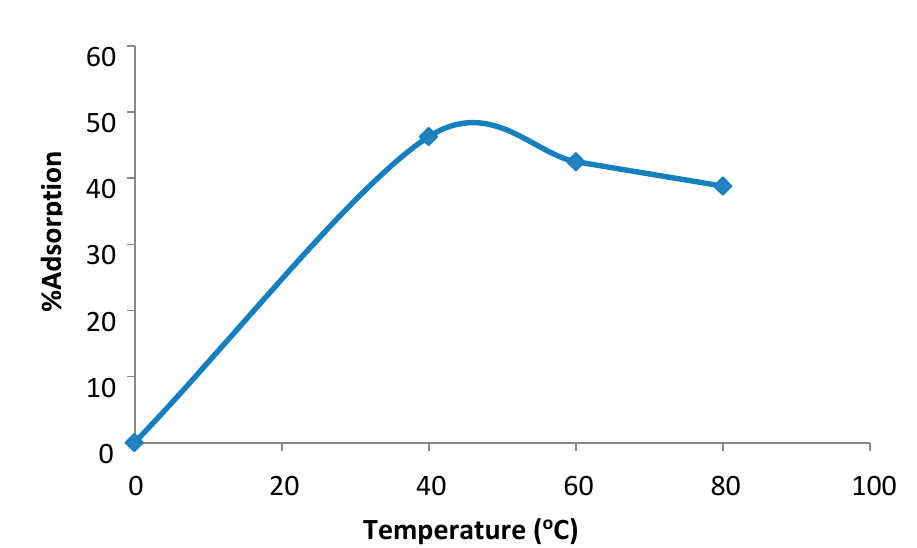
Figure 17. Adsorption capacity and percentage as a function temperature. Reproduced with permission from Reference [162]. Open Access 2015, International Journal of Chemistry.